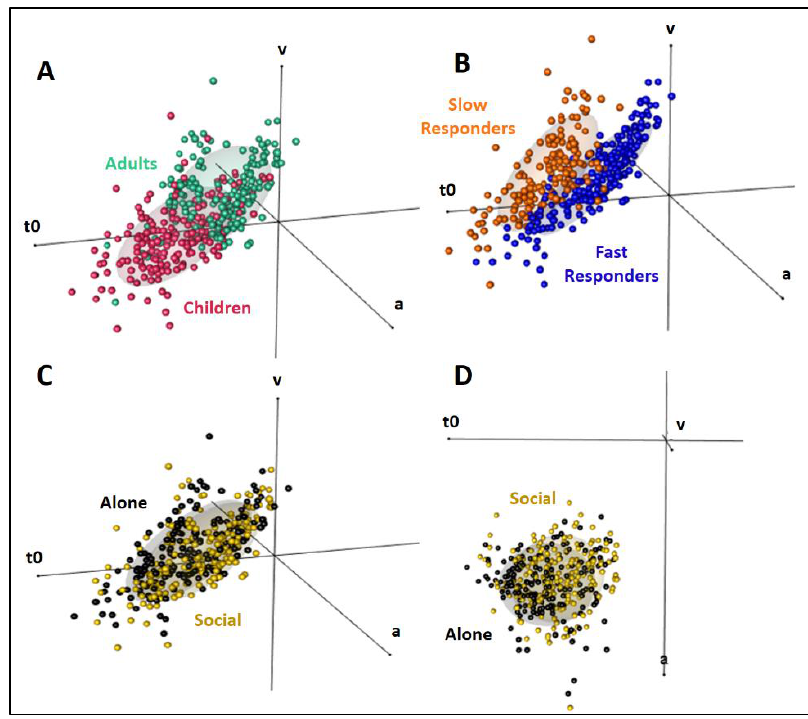
Figure 7. 3-D representation of the diffusion model parameters v (drift rate), a (threshold), and t0 (non-decision time) Figure 3. axis representation. ( A ): Adults (green) vs. children (pink): v was higher, while a and t0 were lower in adults than children. ( B ): Fast responders (blue) vs. slow responders (orange): Only t0 changed, being lower and less variable in fast responders. ( C , D ): Alone (black) vs. Social (yellow) conditions illustrated from two different perspectives. Only t0 changes, being lower in the Social than in the Alone condition.